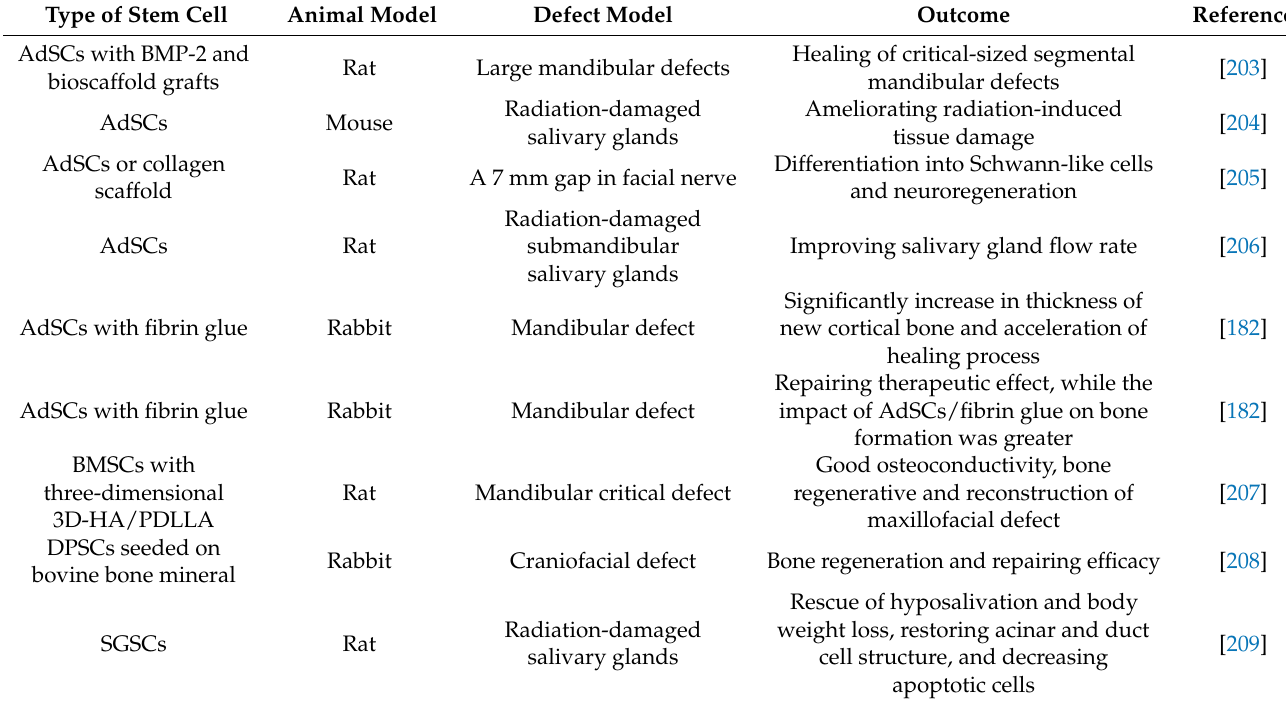
Table 10. In vivo studies of craniofacial